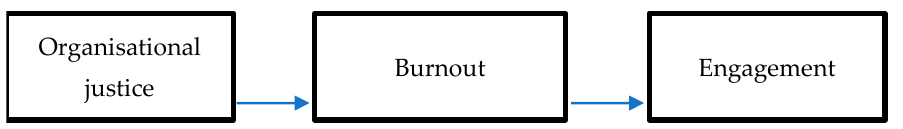
Figure 1. Mediating model (mediated or indirect causal relationship).